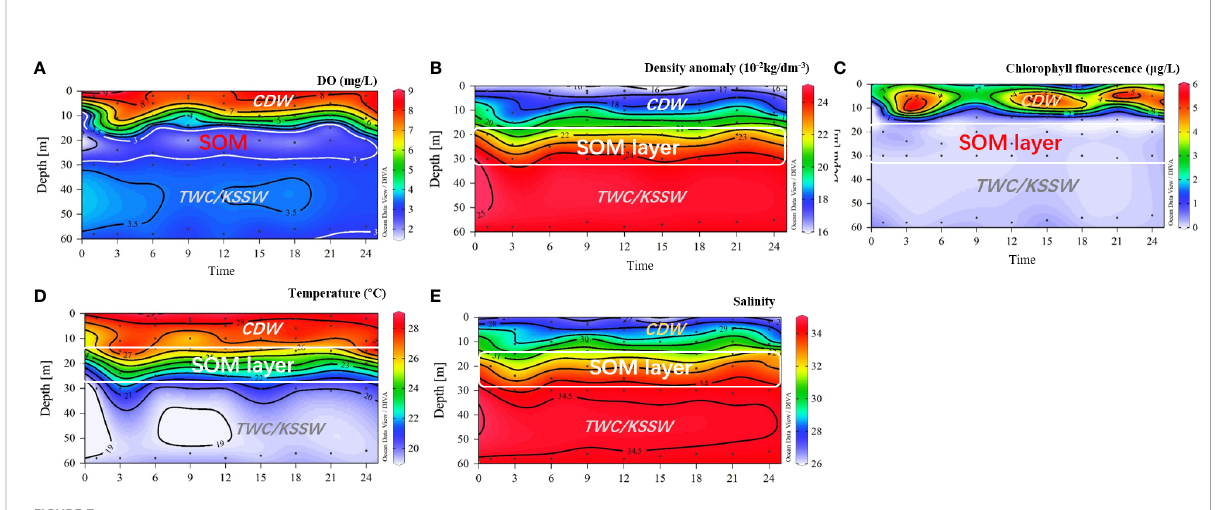
FIGURE 7 Continuous observation for 24 h in station D5. (A) DO; (B) density anomaly; (C) Chl a fl uorescence; (D) temperature; (E) salinity. SOM, subsurface oxygen minimum; CDW, Changjiang diluted